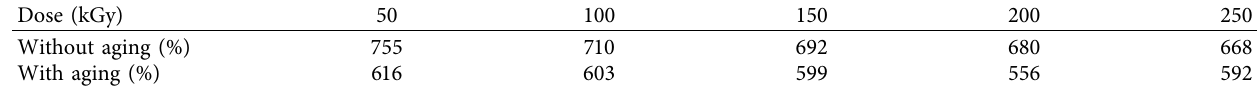
Table 4: The elongation at break of BR/NR blends with different radiation doses.